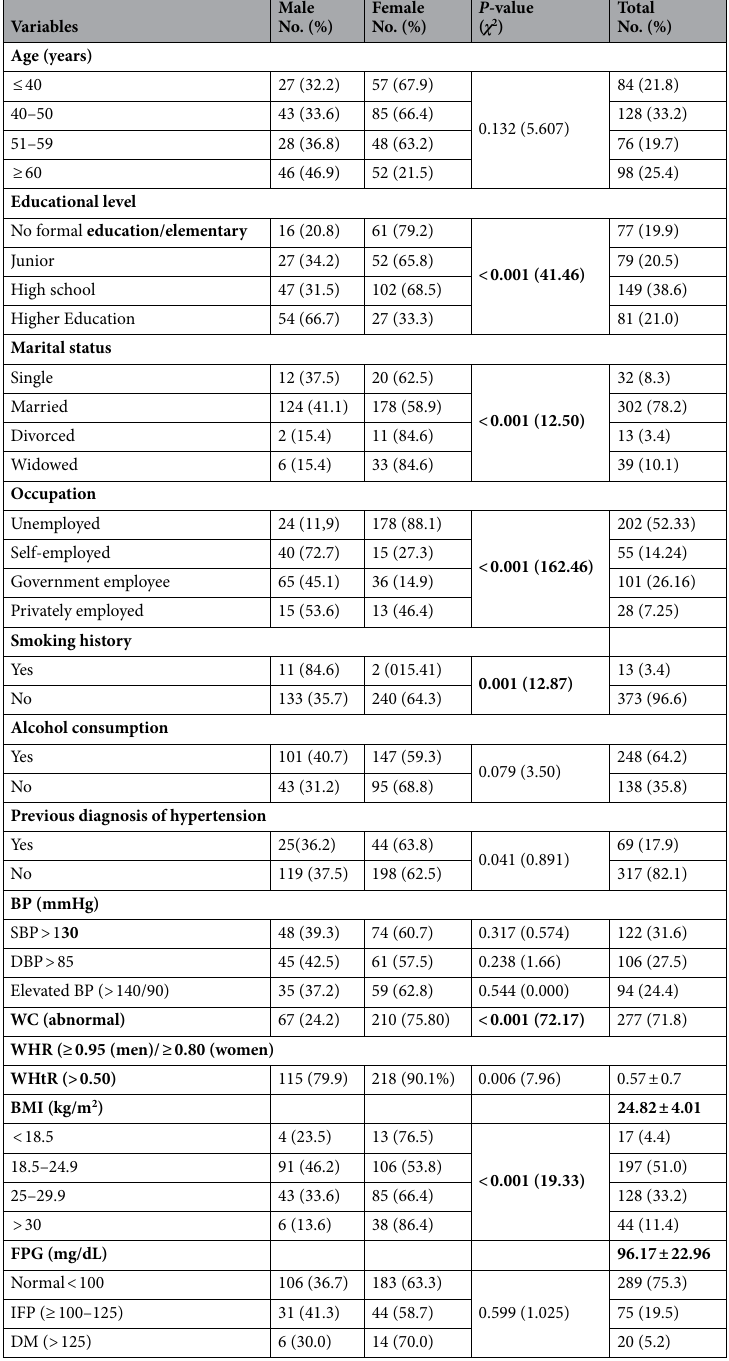
Table 1. Demographic characteristics, patient history, anthropometry, and clinical measurements at inclusion in the study. Significant values are in bold. P values (2 tailed): Frequencies of specific demographic and clinical variables between males and females and associated Chi squire/ Fishers exact test values or student t test values. BP blood pressure, SBP systolic blood pressure, DBP diastolic blood pressure, WC waist circumference, WHR waist/Hip ratio, WHR waist/height ratio, BMI body mass index, FPG fasting plasma